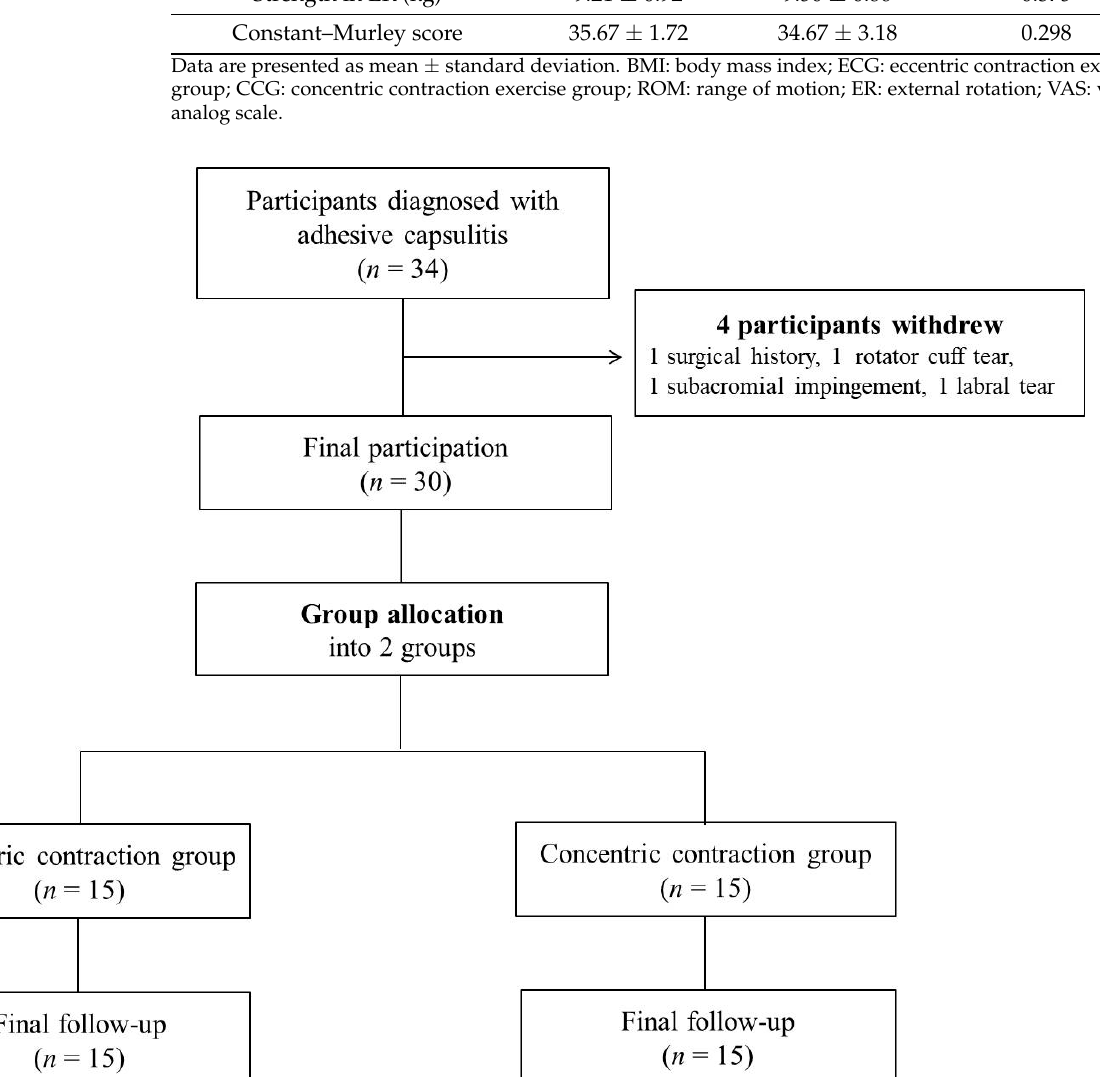
Table 1. Characteristics of the participants in each group.